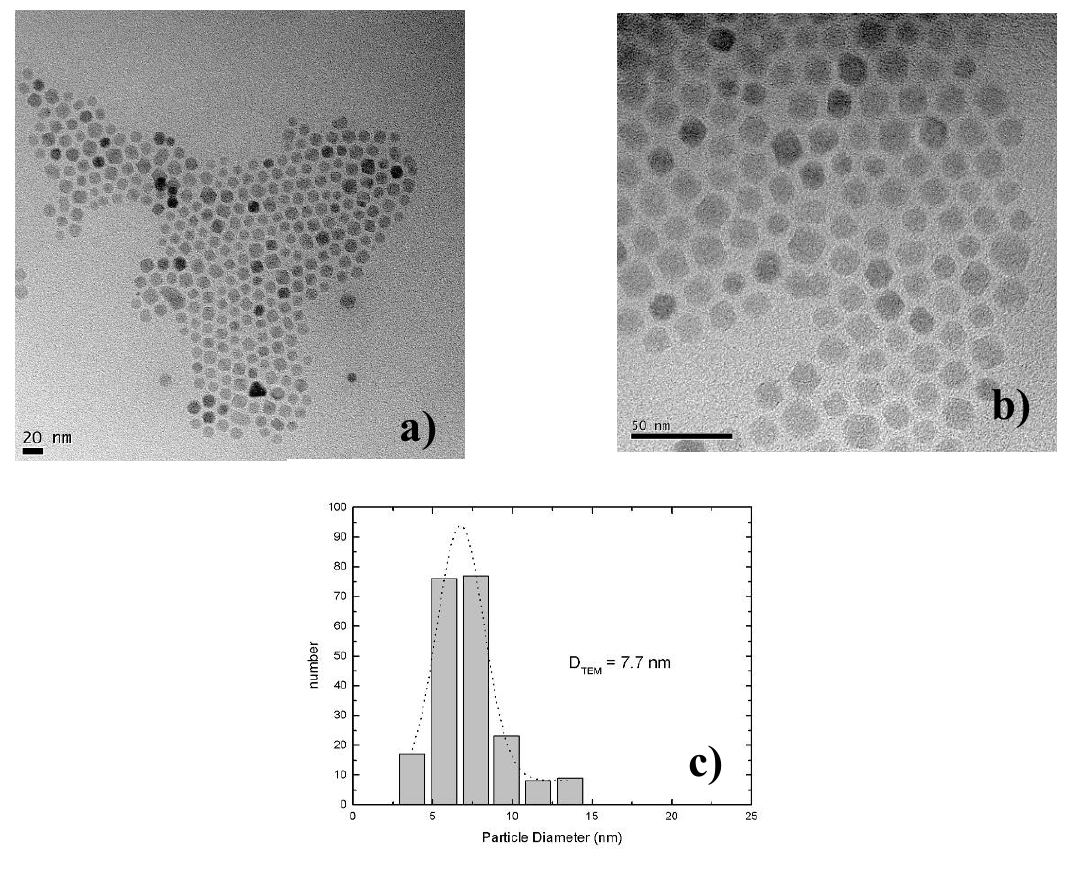
Figure 39. (a) TEM-image of the quite monodisperse magnetite nanoparticles, (b) enhanced region. (c) particle size distribution giving an average diameter of 7.7 nm which is gained from the element (Fe) distribution of the sample due to better contrast (reproduced by permission of The Electrochemical Society